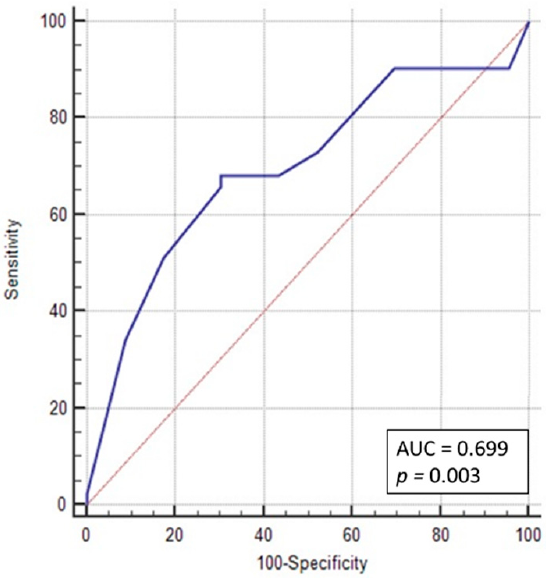
Figure 3. ROC curve for determining the nuclear CD133 cut-off value in FIGO staging. Cut-off point > 50%; p = 0.003; AUC = 0.7; sensitivity = 68.3%; specificity = 69.6%. 3.3. CD133 Expression in the Nucleus and Plasma Membrane Is Positively and Negatively Associated with Tumor Angioinvasion, Respectively Since tumor cell invasion into the vasculature is a crucial feature in tumor